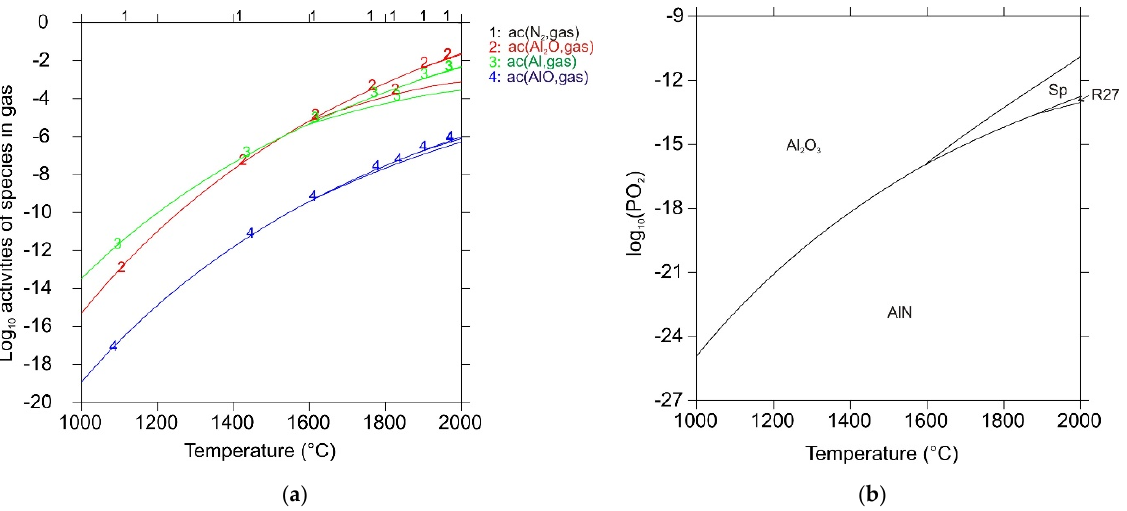
Figure 4. Phase equilibria in the Al 2 O 3 -AlN system Al 2 O 3 +AlN, Al 2 O 3 +spinel AlON, spinel AlON+AlN, R27+spinel AlON, and R27+AlN in the presence of gas: ( a ) temperature dependence of the activities of gas species and ( b ) temperature dependence of the partial pressure of oxygen (in bar).